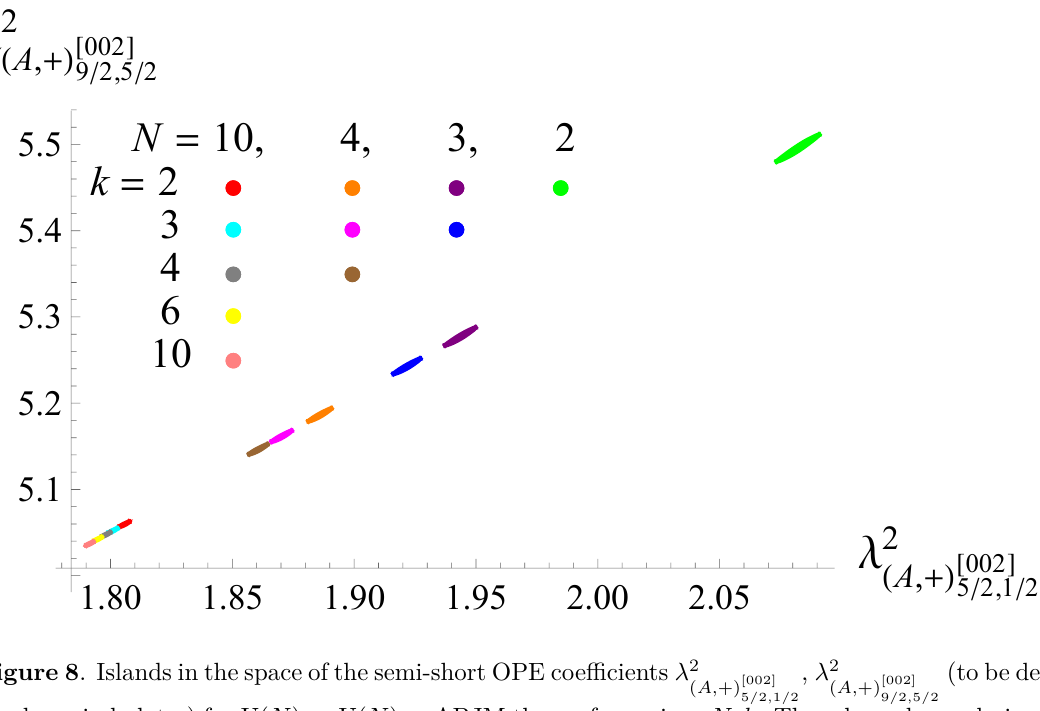
, λ 2 (to be de- ( A, +) [002] ( A, +) [002] 5 / 2 , 1 / 2 9 / 2 , 5 / 2